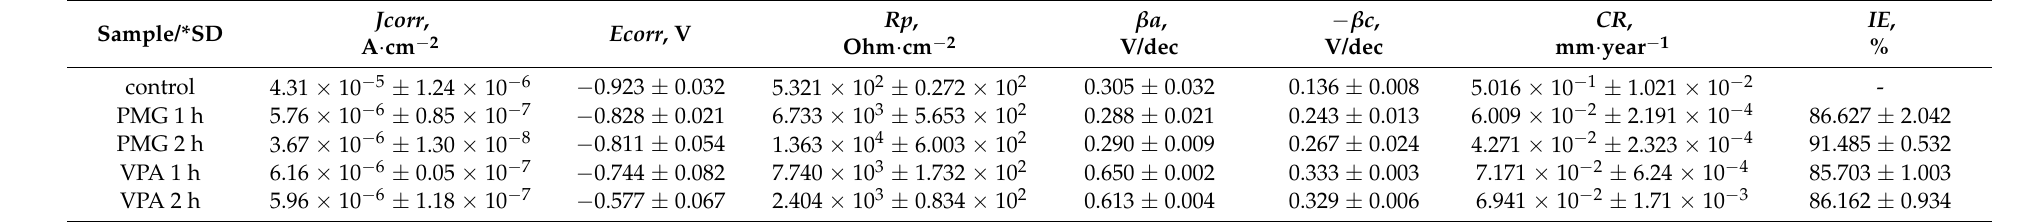
Table 1. Electrochemical parameters for carbon steel maintained in 3% NaCl solution pH = 2.3 with different inhibitors at 22 ◦